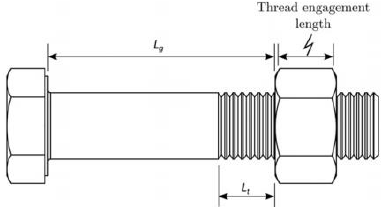
Figure 2. Climbing vehicles or zigzag derailment phenomenon. ( a ) A rear-end collision in the Washington, D.C. Metro in 2009. ( b ) A derailment of a city passenger train in Los Angeles in 2008 (The Railroad Accident Report of the United States National Transportation Safety Board).